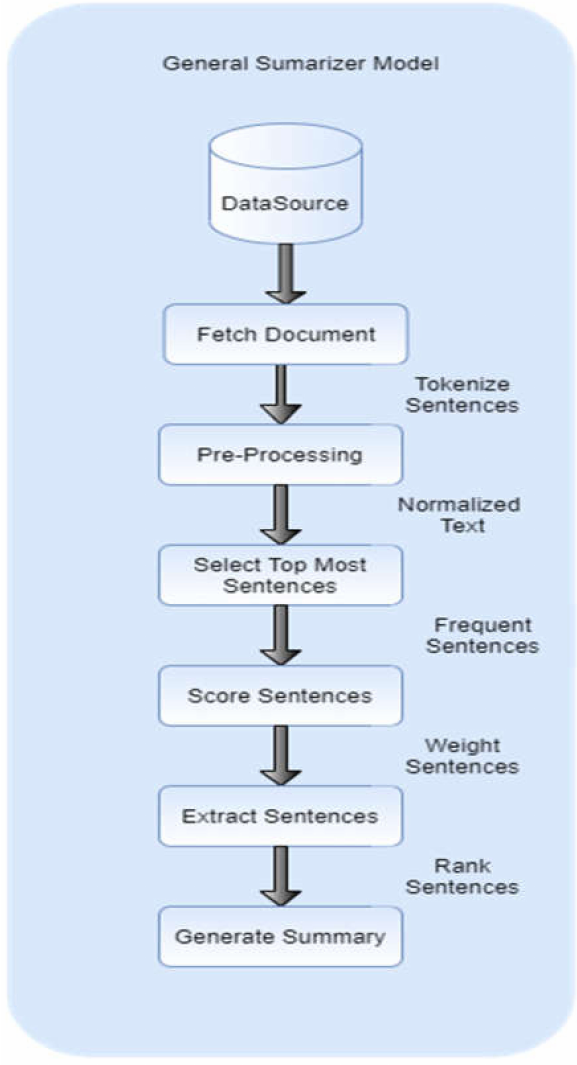
Figure 1. General Summarizer